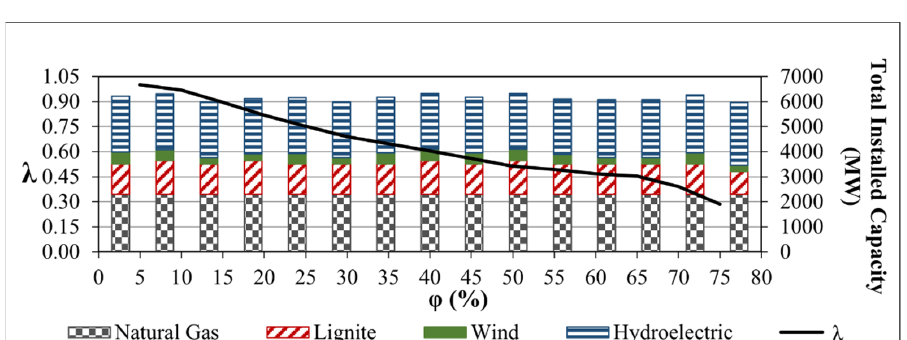
Figure 10. The relationship between φ , λ , and the total installed capacity at the end of the planning horizon. planning